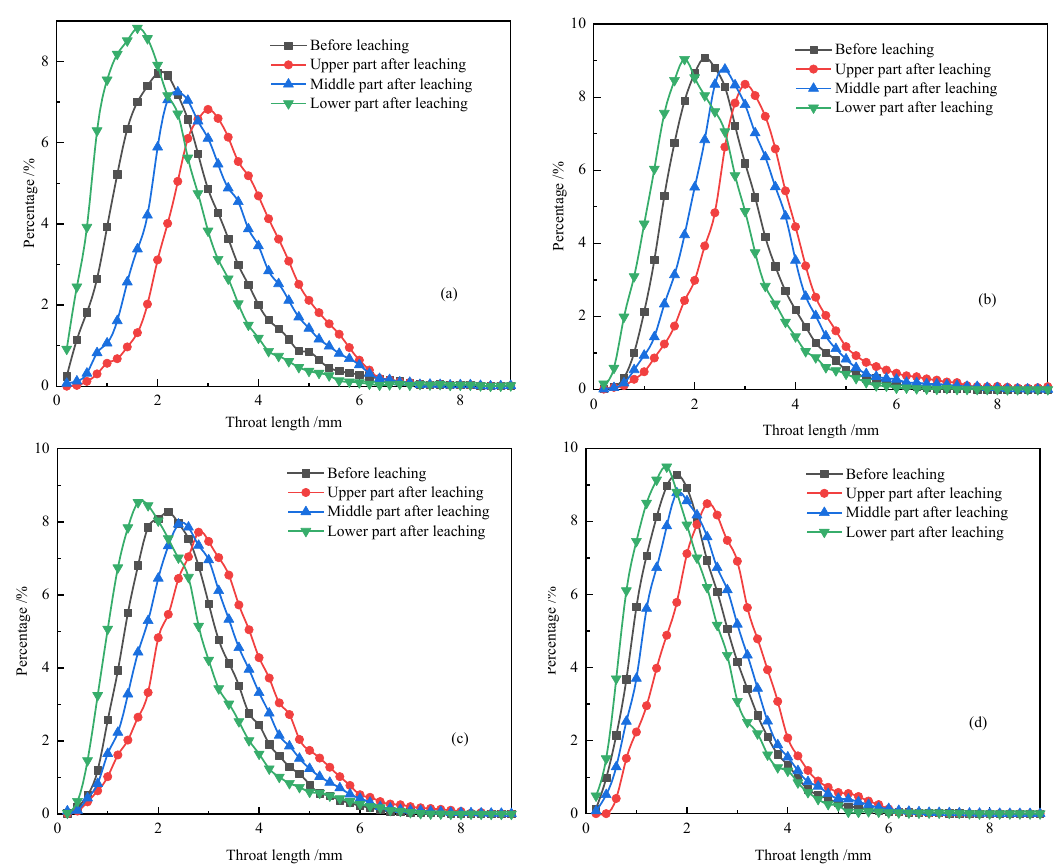
Figure 12. Distribution curves of the pore throat length. ( a ) A D = 2 . 03 ; ( b ) B D = 2 . 23 ; ( c ) C D = 2 . 43 ; ( d ) D D = 2 . 63 .